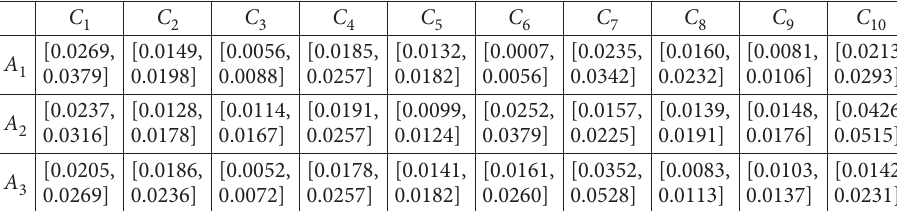
Table 10. Weighted Normalized grey decision support matrix for the alternatives C 1 C 2 C 3 C 4 C 5 C 6 C 7 C